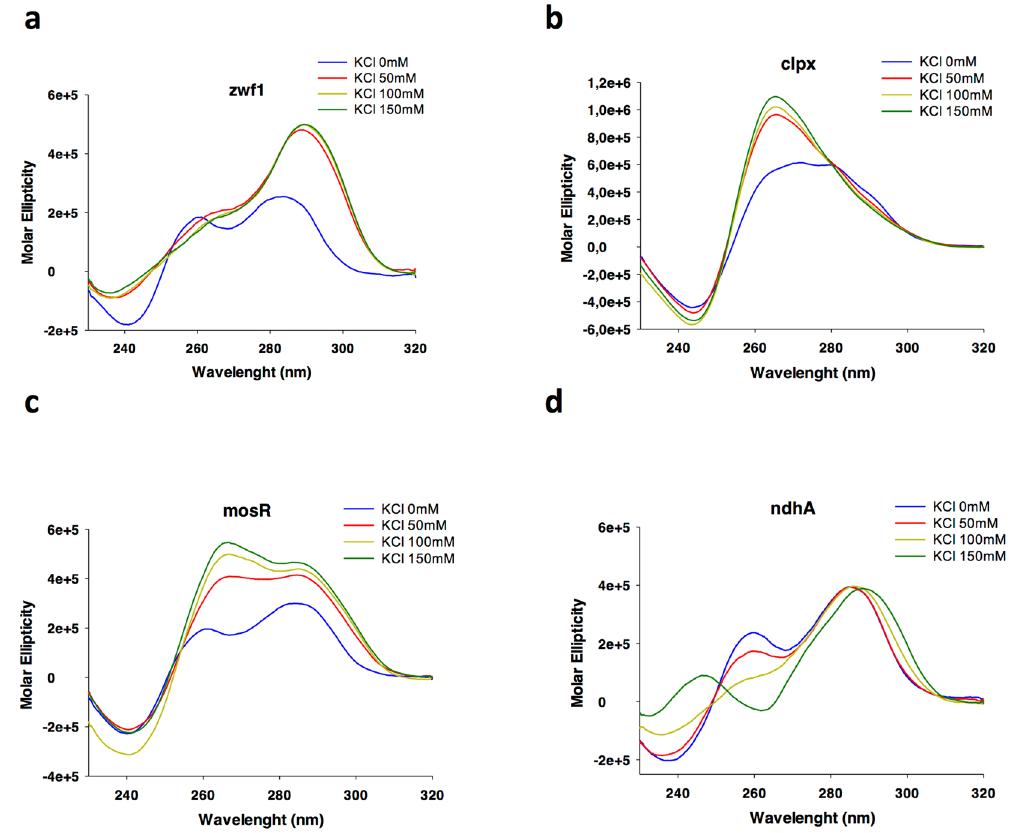
Figure 1. CD spectra of the putative G4 molecules of zwf1 ( a ), clpx ( b ), mosR ( c ) and ndhA ( d ) in the presence of increasing KCl concentrations (0–150